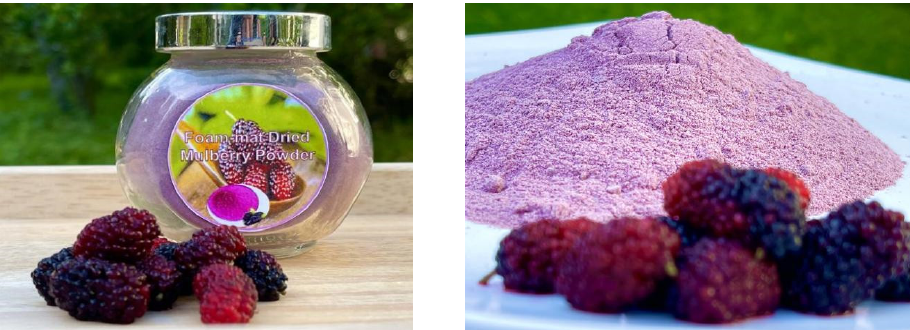
Figure 5. Mulberry powder obtained from the foam-mat drying technique.